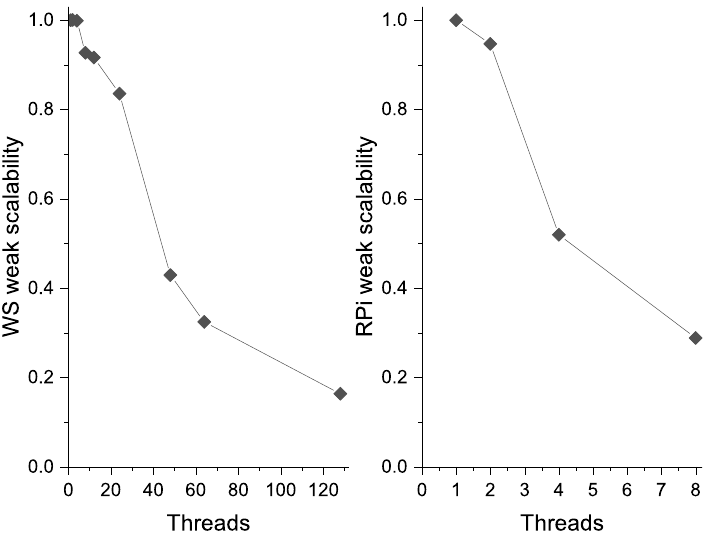
Figure 6. Weak scalability for the workstation and RPi depending on the number of threads. Au- tomaton size: 4 m × 4